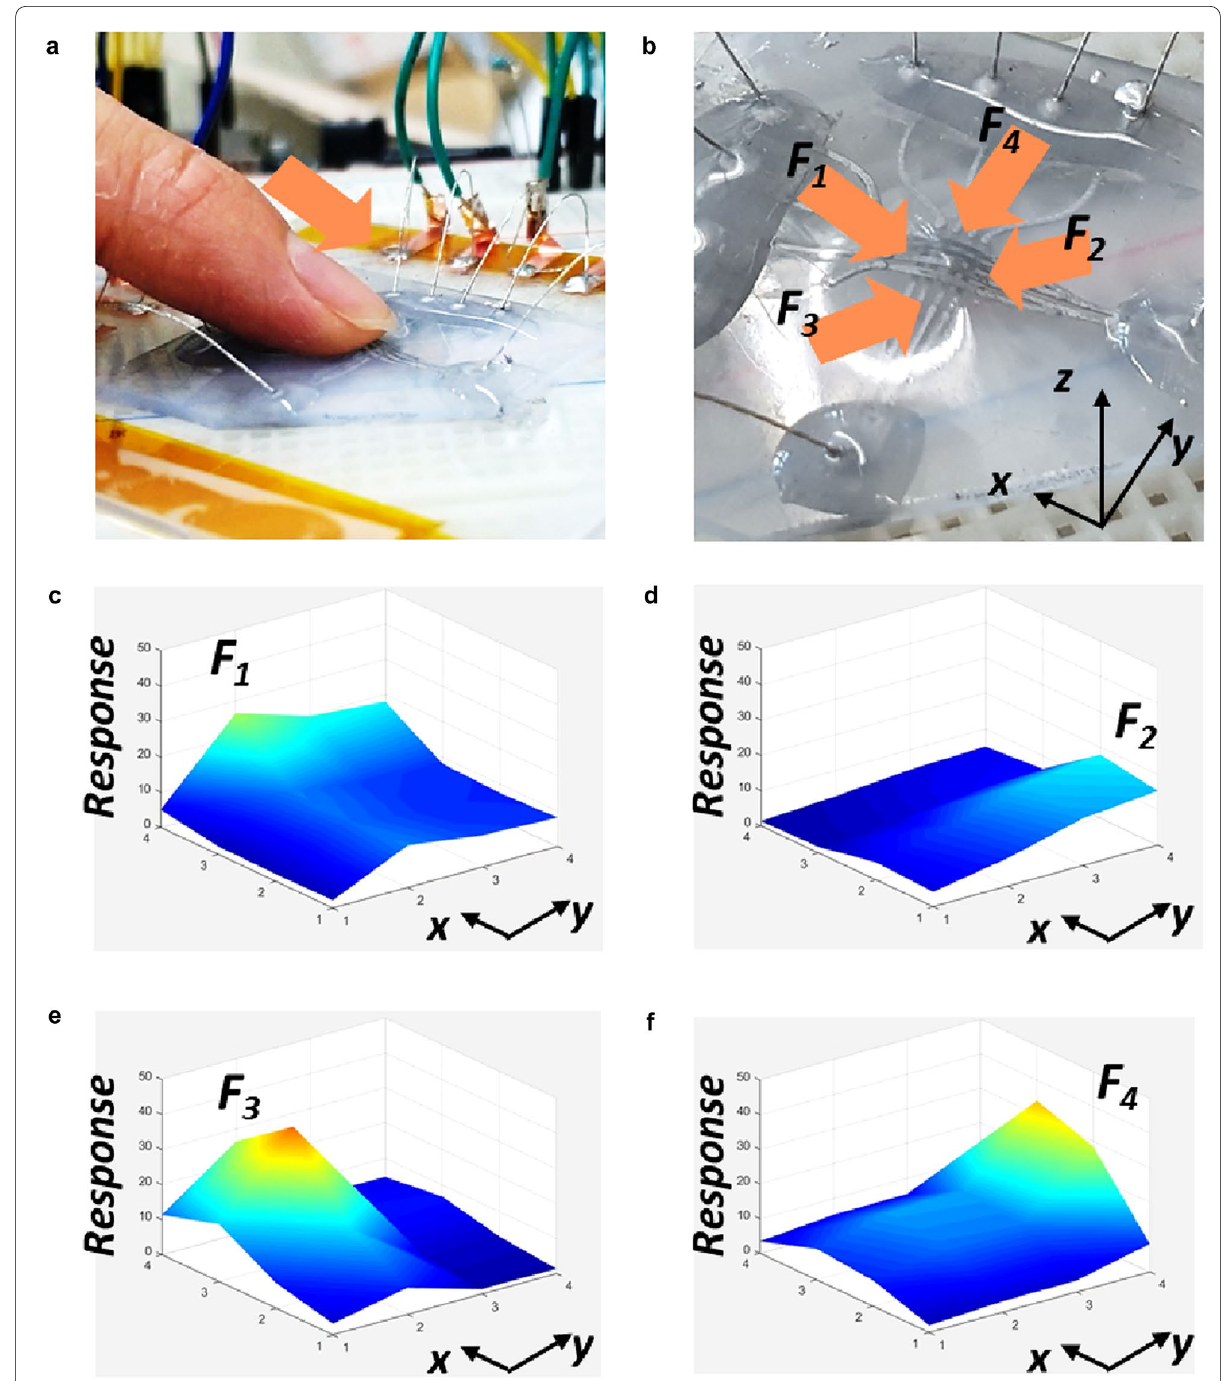
Fig. 5 Application: finger force detection. a Image of a finger applying the force. b Various loading condition. c – f Responses to the various loading